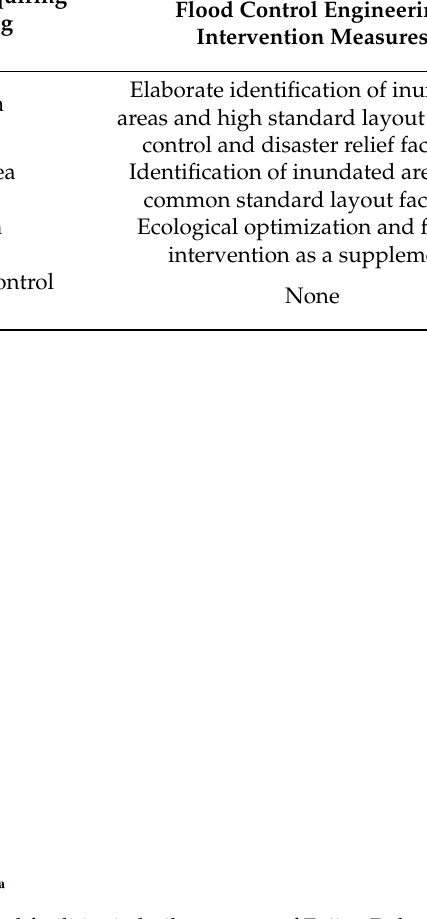
Figure 17. Regional intervention of flood control facilities in built-up areas of Fujian Delta based on a comparison of FRES supply and demand. comparison of FRES supply and